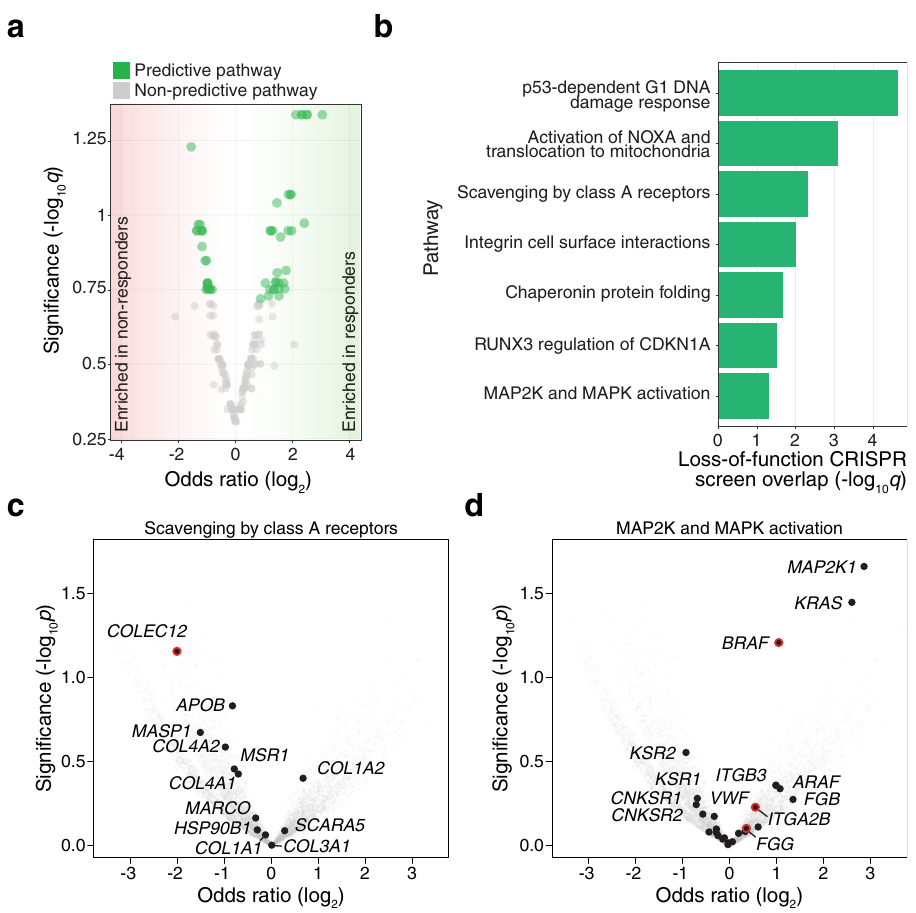
Fig. 4 Somatic mutations in genes encoding DNA damage, immune-associated, and mitogen-activated protein kinase (MAPK) pathways correlate with ICB response. a Volcano plot of fi shHook-nominated pathways with log 2 odds ratio for ICB response ( x -axis) and signi fi cance of association with ICB response ( y -axis). Statistical signi fi cance was tested using a two-sided Wald ’ s test of coef fi cients with multiple-hypothesis correction (FDR < 0.2). b fi shHook-nominated pathways that overlap top-ranked genes from a genome-wide CRISPR screen for immunotherapy resistance (FDR-corrected one- sided hypergeometric test). c – d Volcano plots of odds ratio (responders/non-responders) and nominal p -values for genes in two of the fi shHook- nominated pathways: Scavenging by Class A Receptors ( c ) and MAP2K and MAPK Activation ( d ). Red outlines indicate genes that were also found in the CRISPR screen. Indicated p -values are from the fi shHook model using the observed mutation rate for each